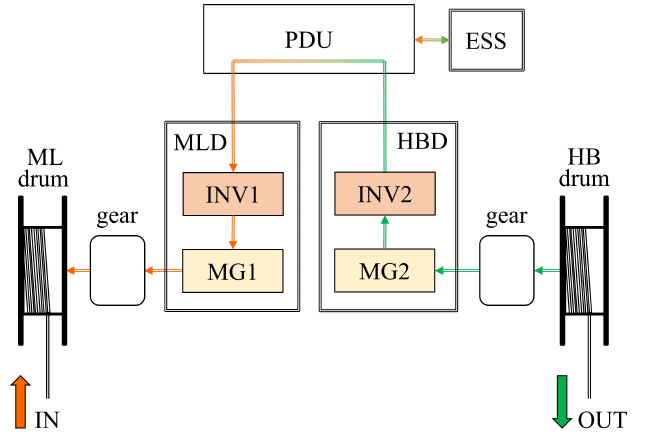
Figure 8. Energy flow in MLD, HBD, and ESS during hauling in with two independently controlled electric